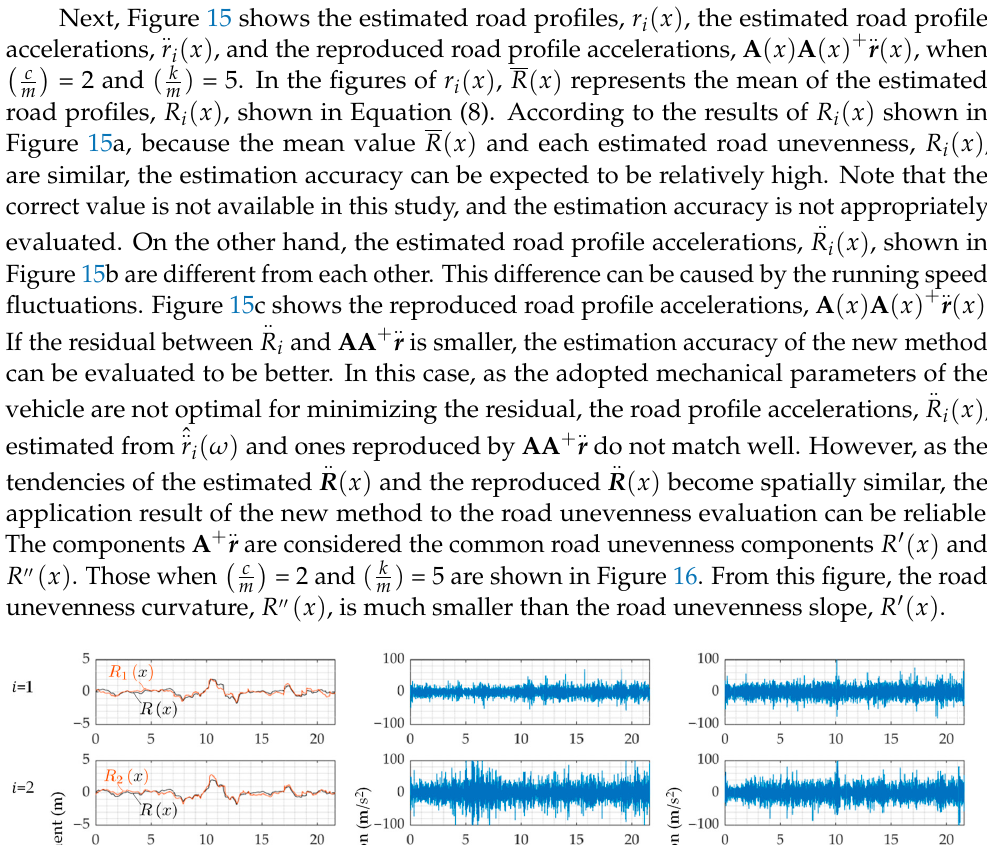
(cid:4673) and (cid:4672) (cid:3038) (cid:4673) optimizing 𝐽 (cid:2869) (cid:3040) (cid:3040)